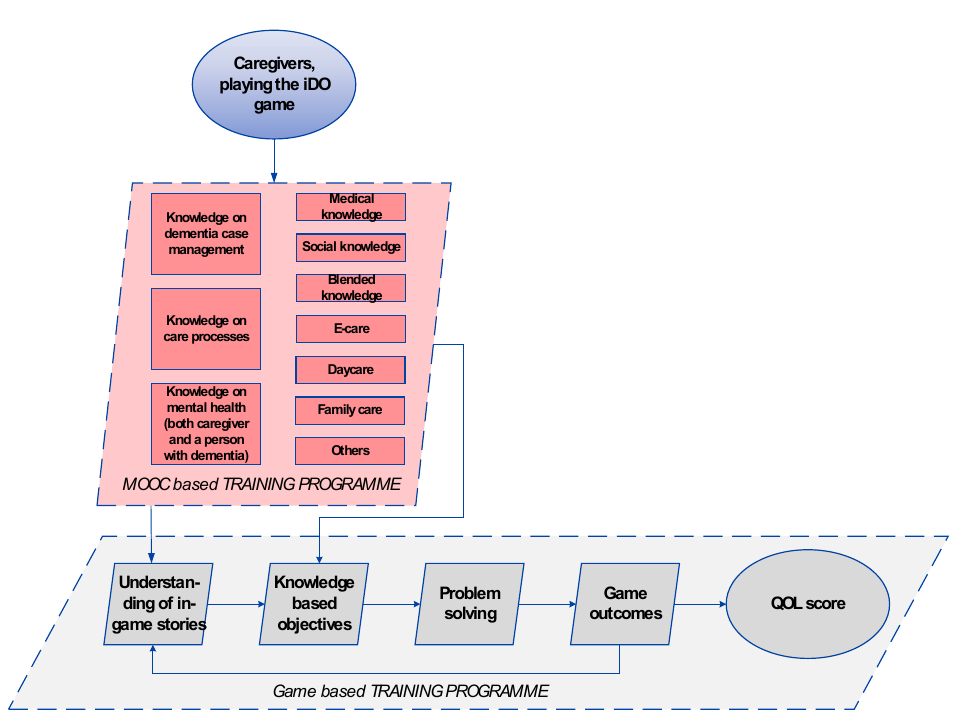
Figure 1. Educational model for the iDO gameplay. MOOC - massive open online course. QOL – Quality of Life.